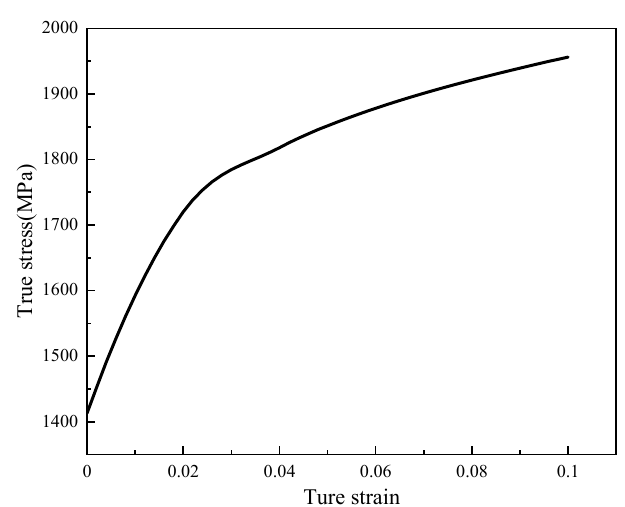
Figure 14. The true stress-plastic strain curve. The initial residual stress field is defined before starting the response history. The hexahedral element has six stress components ( σ 11 , σ 22 , σ 33 , σ 12, σ 13, σ 23 ). The shear stress and the stress in the depth direction are negligible according to the above residual stress measurement. Therefore, normal stress components σ 11 and σ 33 , confirmed at residual stress σ r (Figures 10 and 11), are applied to the element integration points of the model (Figure 13). The repetitive work of initial residual stress application can be reduced through the secondary development of Python. After the initial stress field is applied in the finite element model, the equivalent node load formed by the stress field need to be in equilibrium with the specified boundary conditions. Therefore, a static analysis step without external load is set to obtain the actual residual stress field. The actual residual stress obtained by adding different types of residual stress curves (Figures 10 and 11) is shown in Figure 15. The variation of initial residual stress after equilibrium is negligible, which verifies that the method of applying the initial residual stress field to this model is reasonable.